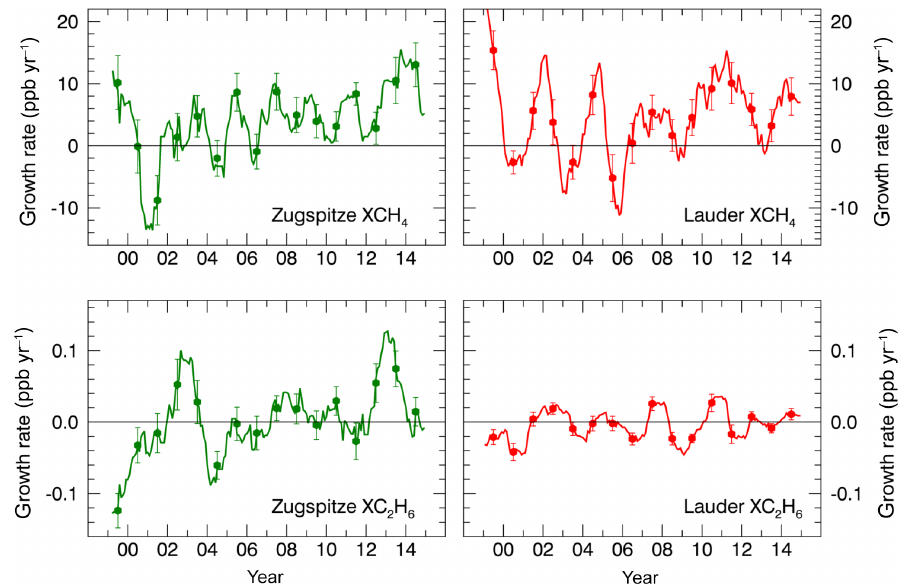
Figure A1. Annual growth rates of column-averaged methane and ethane at Zugspitze (left panels) and Lauder (right panels). Annual increases are calculated as the difference between two consecutive annual means (filled circles). Annual running mean growth rates are depicted as solid lines (see text for details). Table B1. Uncertainty of methane two-box model parameters and implied trend uncertainty. Model